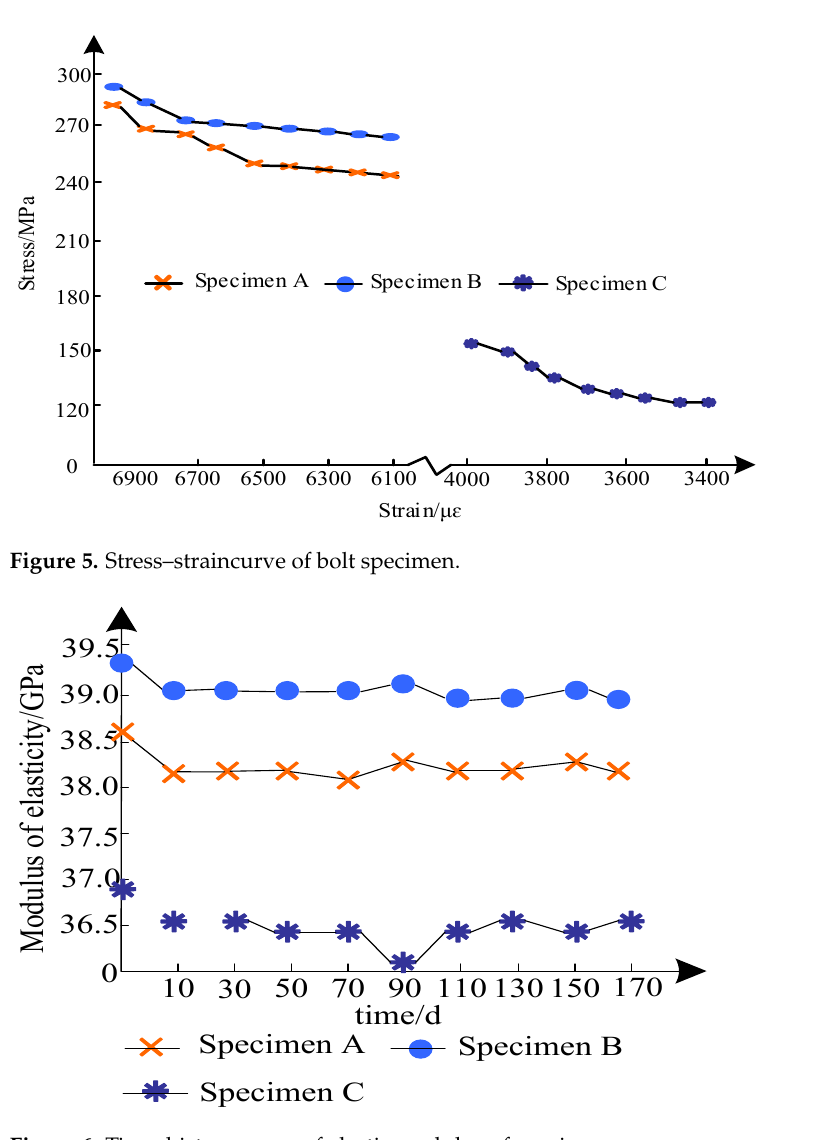
Figure 6. Time–history curve of elastic modulus of specimens.